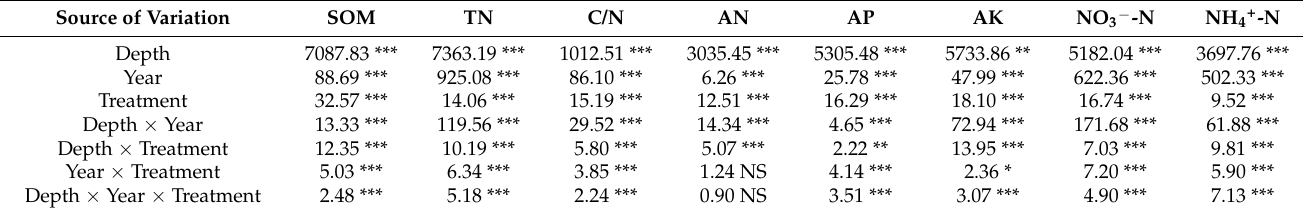
Table 1. The interaction of soil depth, experimental years, and treatment with soil properties. Source of